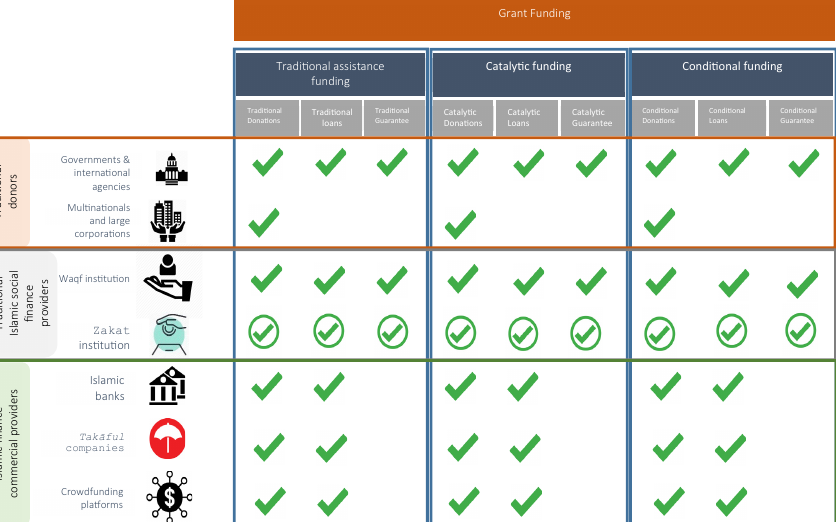
Figure 3. Types of